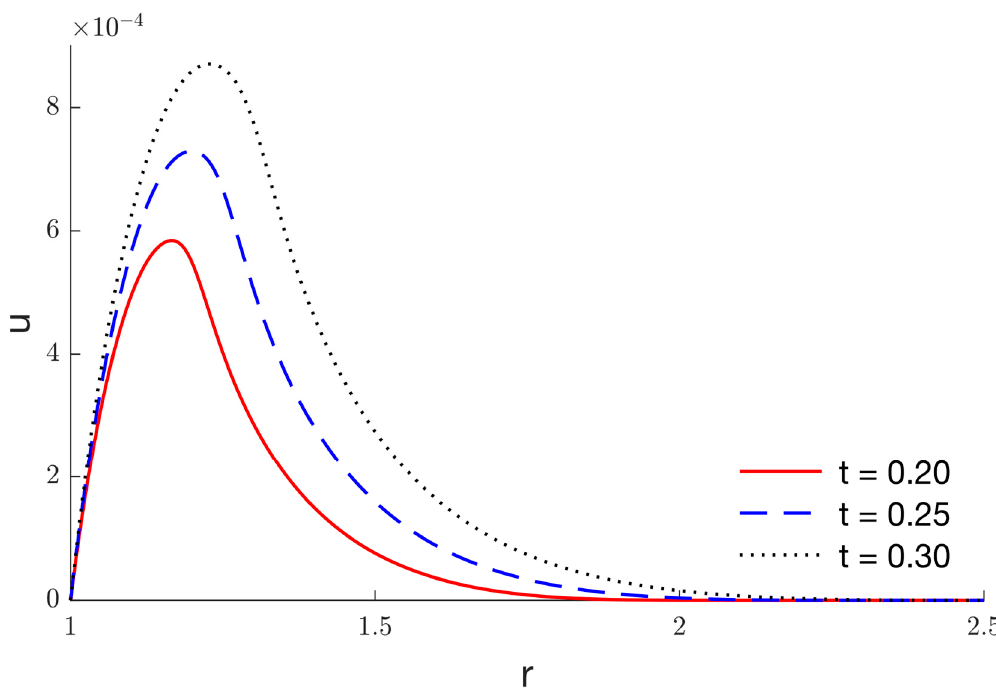
Figure 11. The radial displacement variation 𝑢 for different values of time.